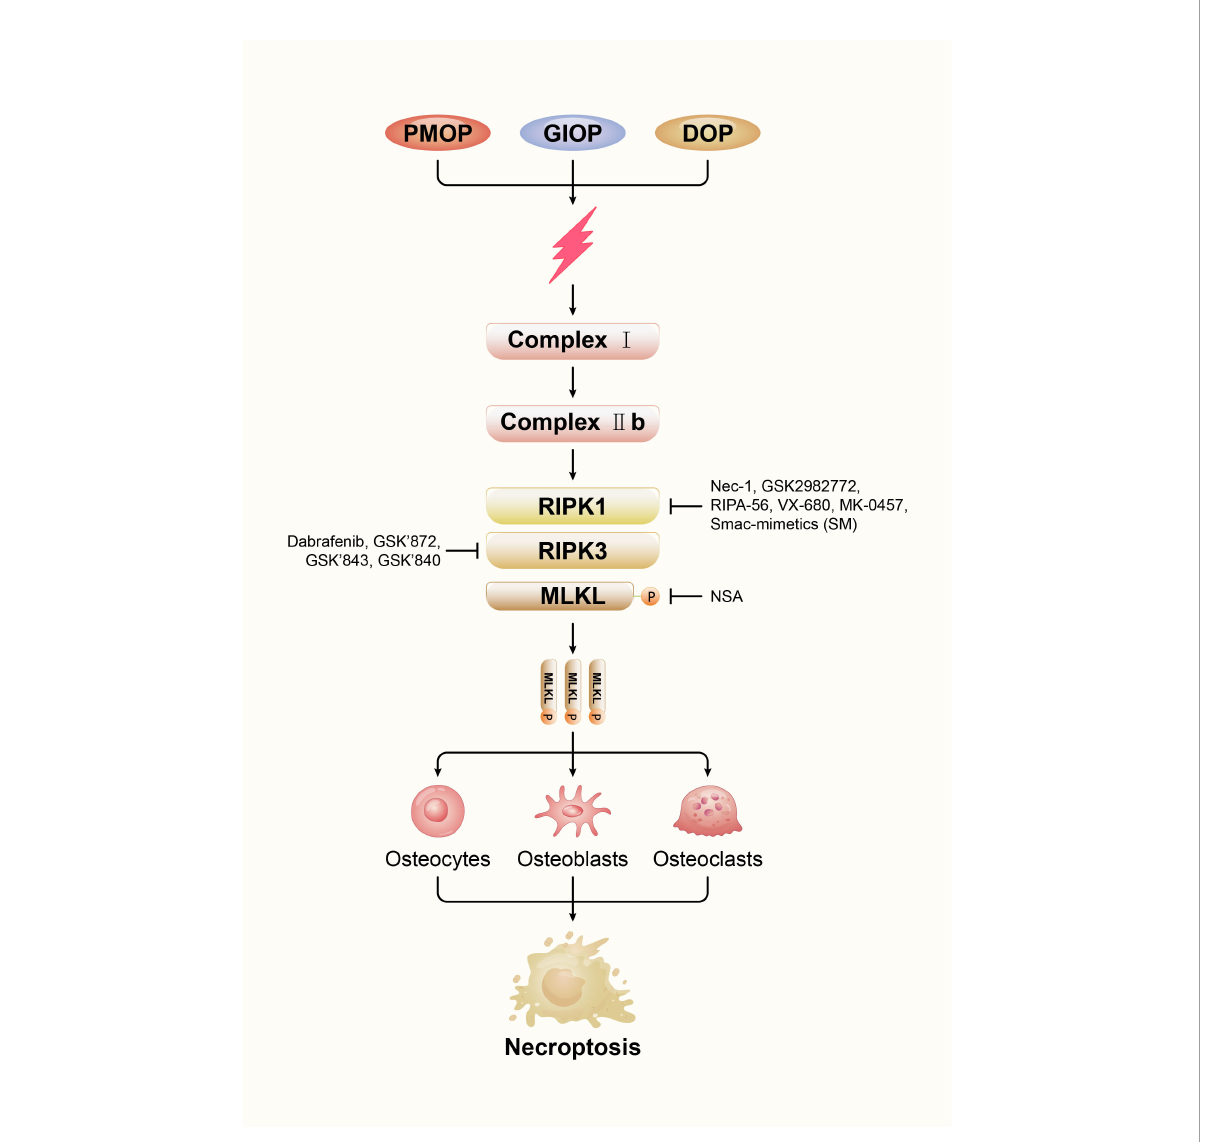
FIGURE 3 Effects of various therapeutic inhibitors of necroptosis on components of